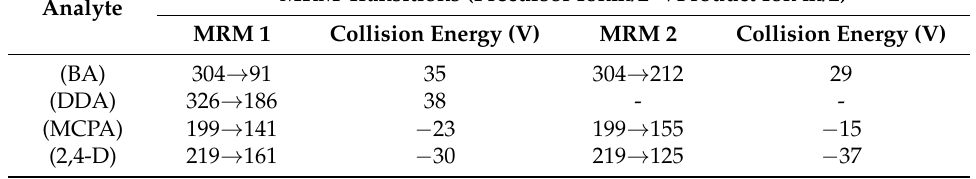
Table 2. Parameters of mass spectrometric detection characteristic for the particular analytes. Analytical multiple reaction monitoring transition (MRM 1). Confirmatory multiple reaction monitoring transition (MRM